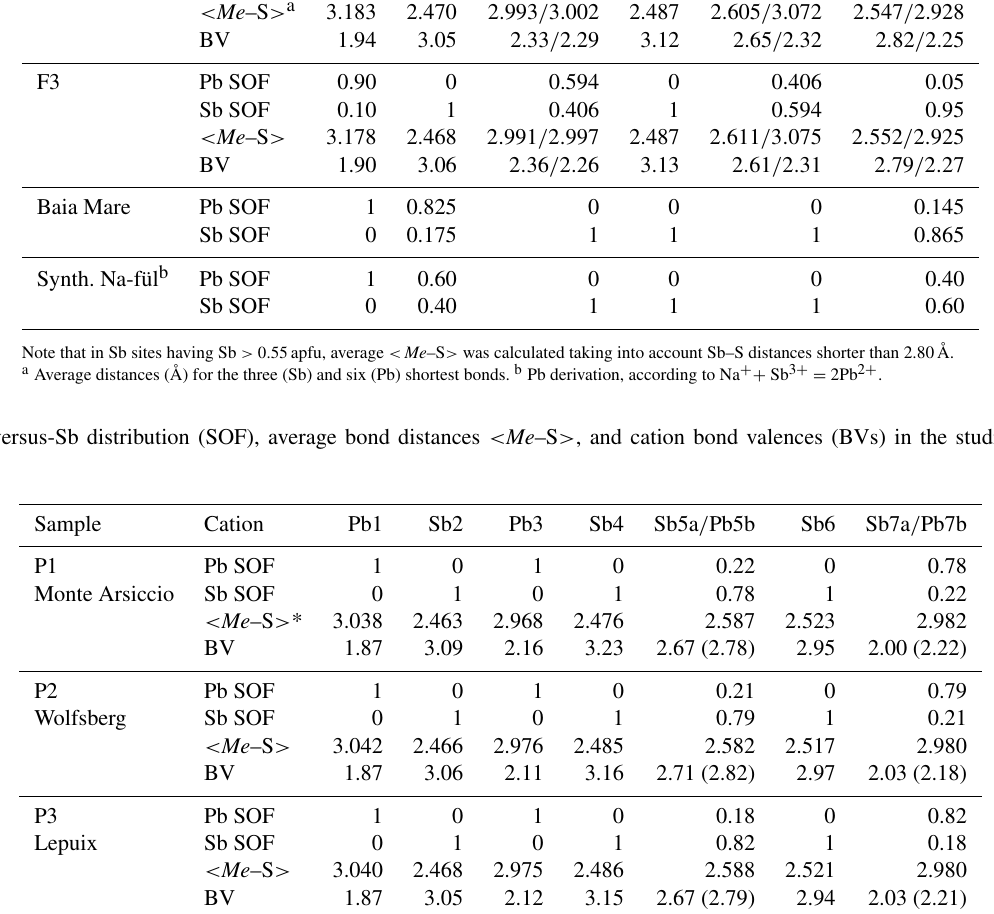
x according to this table. The two continuous lines represent the interpolated curves between measured values of A/B and C/D ratios, while the two tie lines correspond to the extrap- olated curves obtained starting from the crystal structure of the F1 sample, with x varying from 0 to